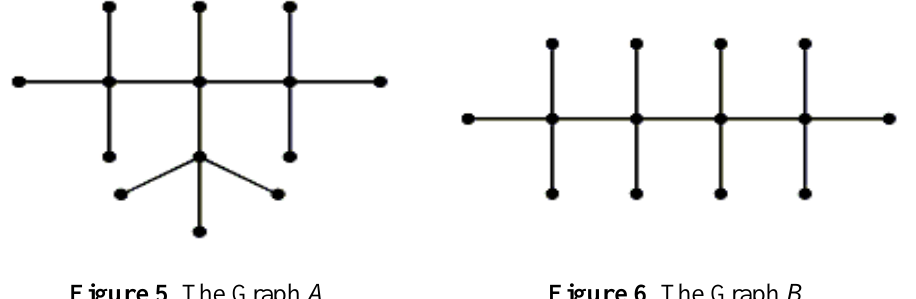
Figure 5 . The Graph A . Figure 6 . The Graph B .